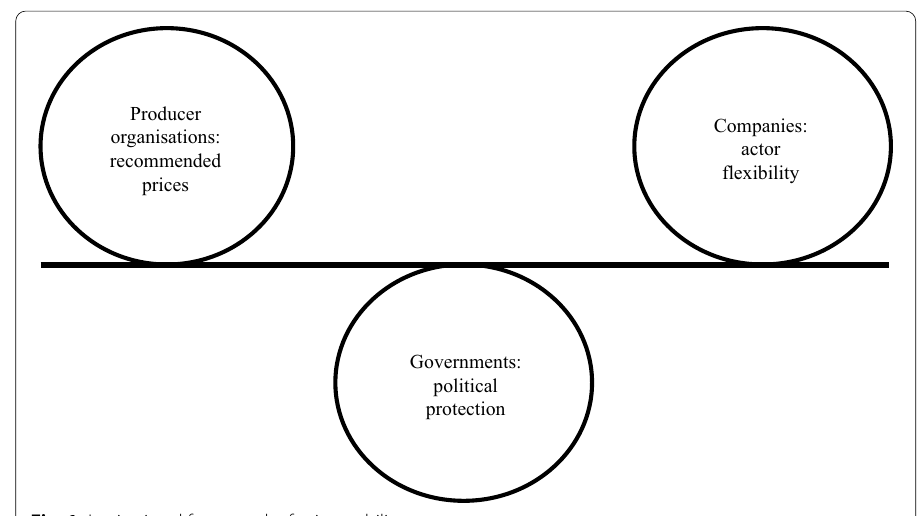
Fig. 1 Institutional framework of price